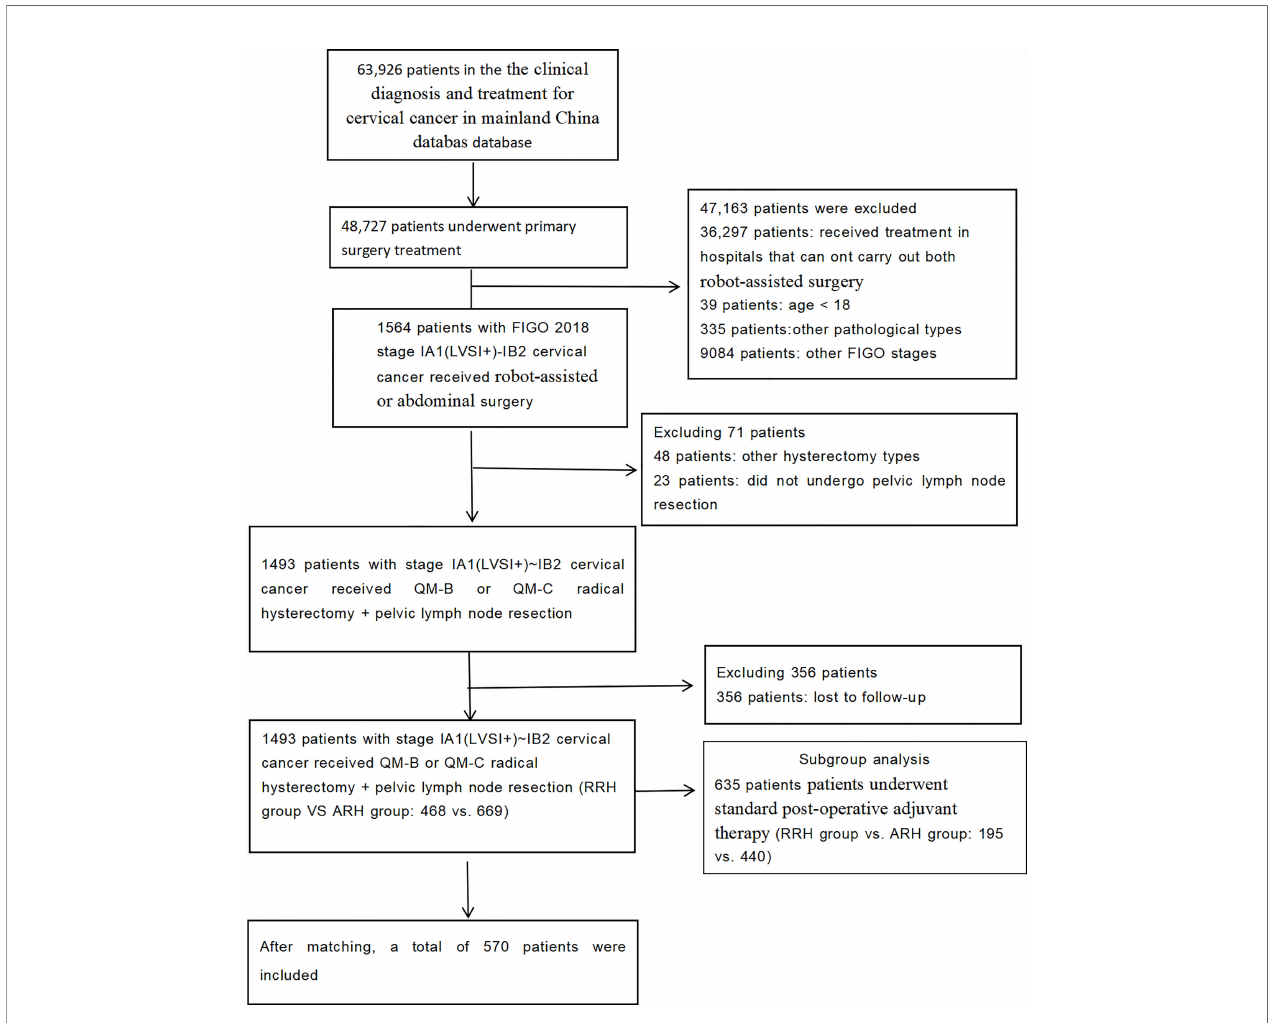
FIGURE 1 | Flowchart of patients included in the